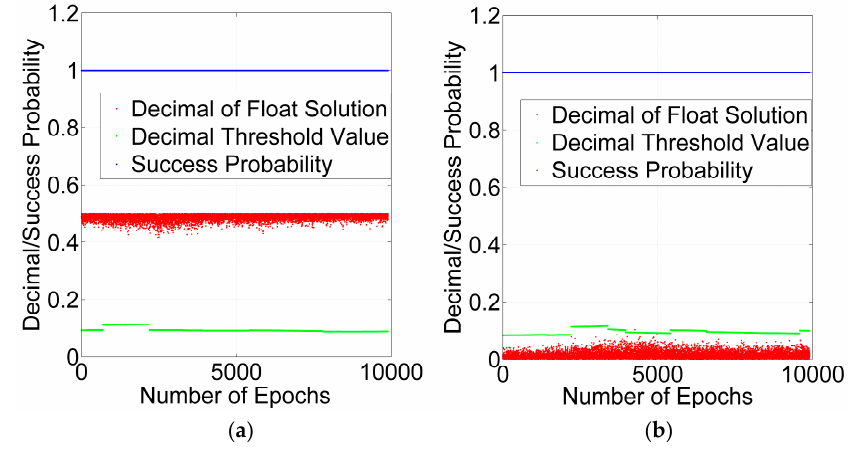
Figure 11. Validation by success probability and decimal test for GPS + BDS: 1.5 Cycles ( a ); 1 Cycle ( b ).